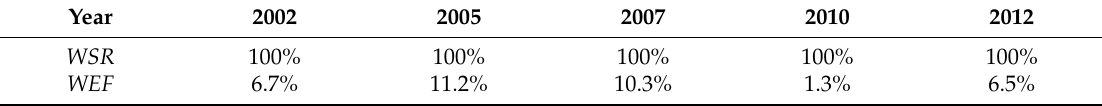
Table 6. Water self-reliance and water export fraction in China from 2002 to